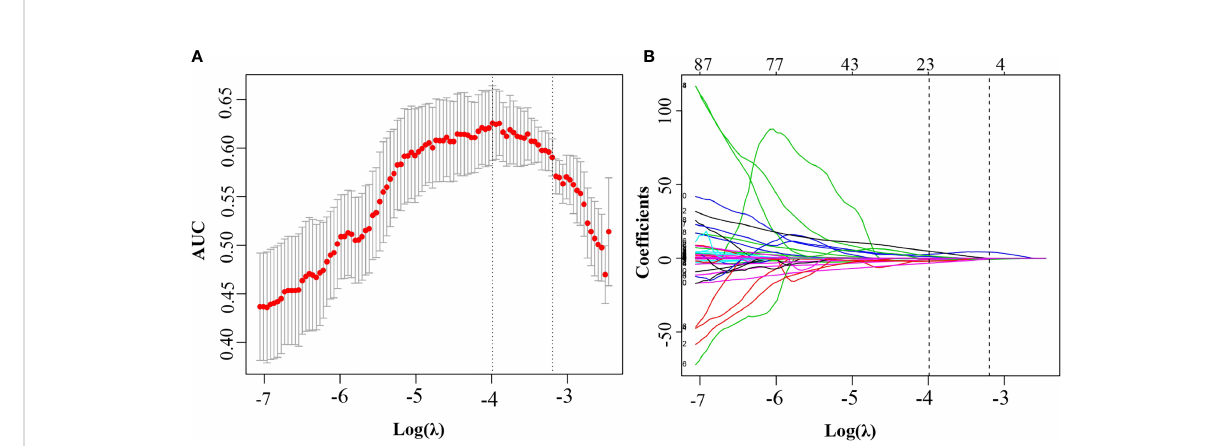
FIGURE 2 Feature selection using the least absolute shrinkage and selection operator regression model. (A) Selection of tuning parameter ( l ) in the LASSO model used 8-fold cross-validation via minimum criteria. The area under the receiver operating characteristic (AUC) curve was plotted versus log( l ). Dotted vertical lines were drawn at the optimal values by using the minimum criteria and the 1 standard error of the minimum criteria (the 1-SE criteria). The optimal l value of 0.019 with log ( l ) of − 3.988 was chosen. (B) LASSO coef fi cient pro fi les of the 530 selected features. A coef fi cient pro fi le plot was produced against the log ( l ) sequence. A vertical line was plotted at the optimal l value, which resulted in 22 features with nonzero coef fi